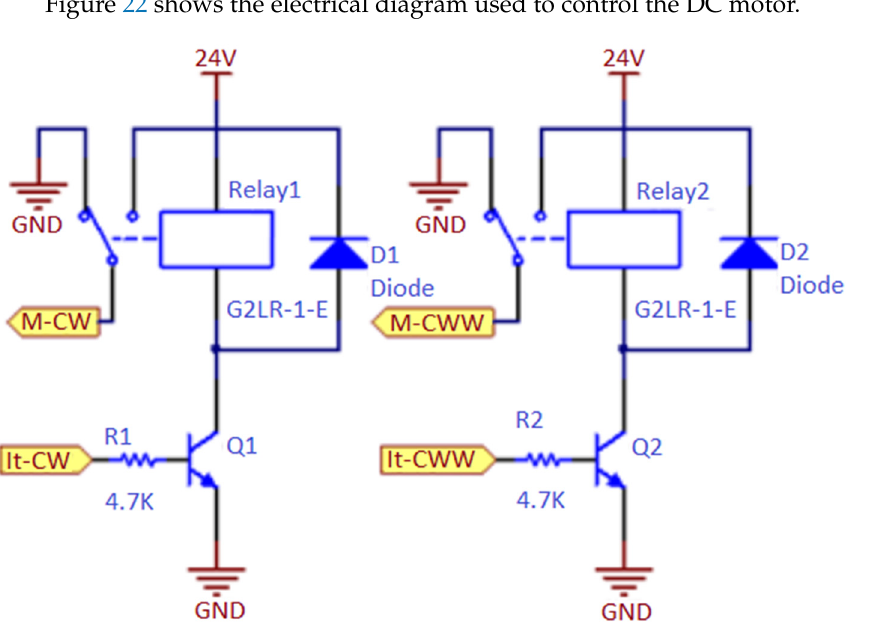
Figure 22. Electric scheme of the DC motor’s drive.